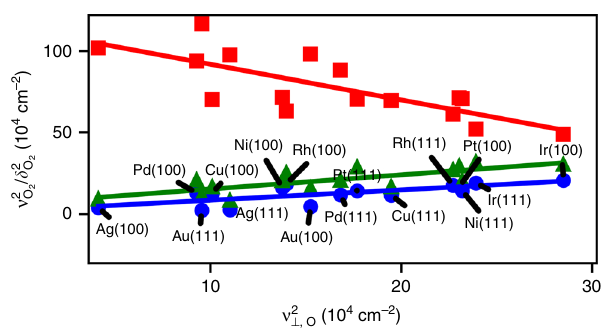
Fig. 7 Scaling of O 2 frequencies vs. atomic O frequencies calculated from DFT. Modes shown include the ν ⊥ stretch mode of O 2 (blue circles), δ ⊥ rotation of O 2 (green triangles), and the O – O stretch (red squares). Frequencies of atomic oxygen are for the ν ⊥ mode. DFT calculations are for adsorption on (100) and (111) fcc transition metal surfaces. Atomic O is at the most stable site in each case and O 2 is at the bridge site parallel to the surface. Only the points corresponding to the ν ⊥ (M – O 2 ) modes are labeled, as all DFT frequencies are for these metals. The slopes of the regressed lines are − 2.19, 0.87, and 0.63 for the red, green, and blue lines, respectively. The intercepts are all